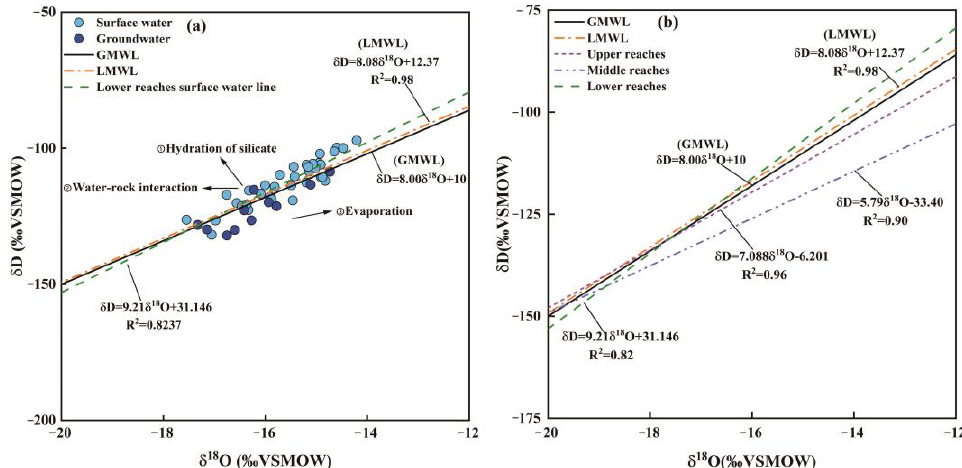
Figure 14. Relationship between surface water and groundwater δ D and δ 18 O in the middle and lower reaches of the Yarlung Zangbo River ( a ) and comparison of surface water lines in the middle and lower reaches, middle and upper reaches of the Yarlung Zangbo River ( b ). Data are from Tables 1 and 2.